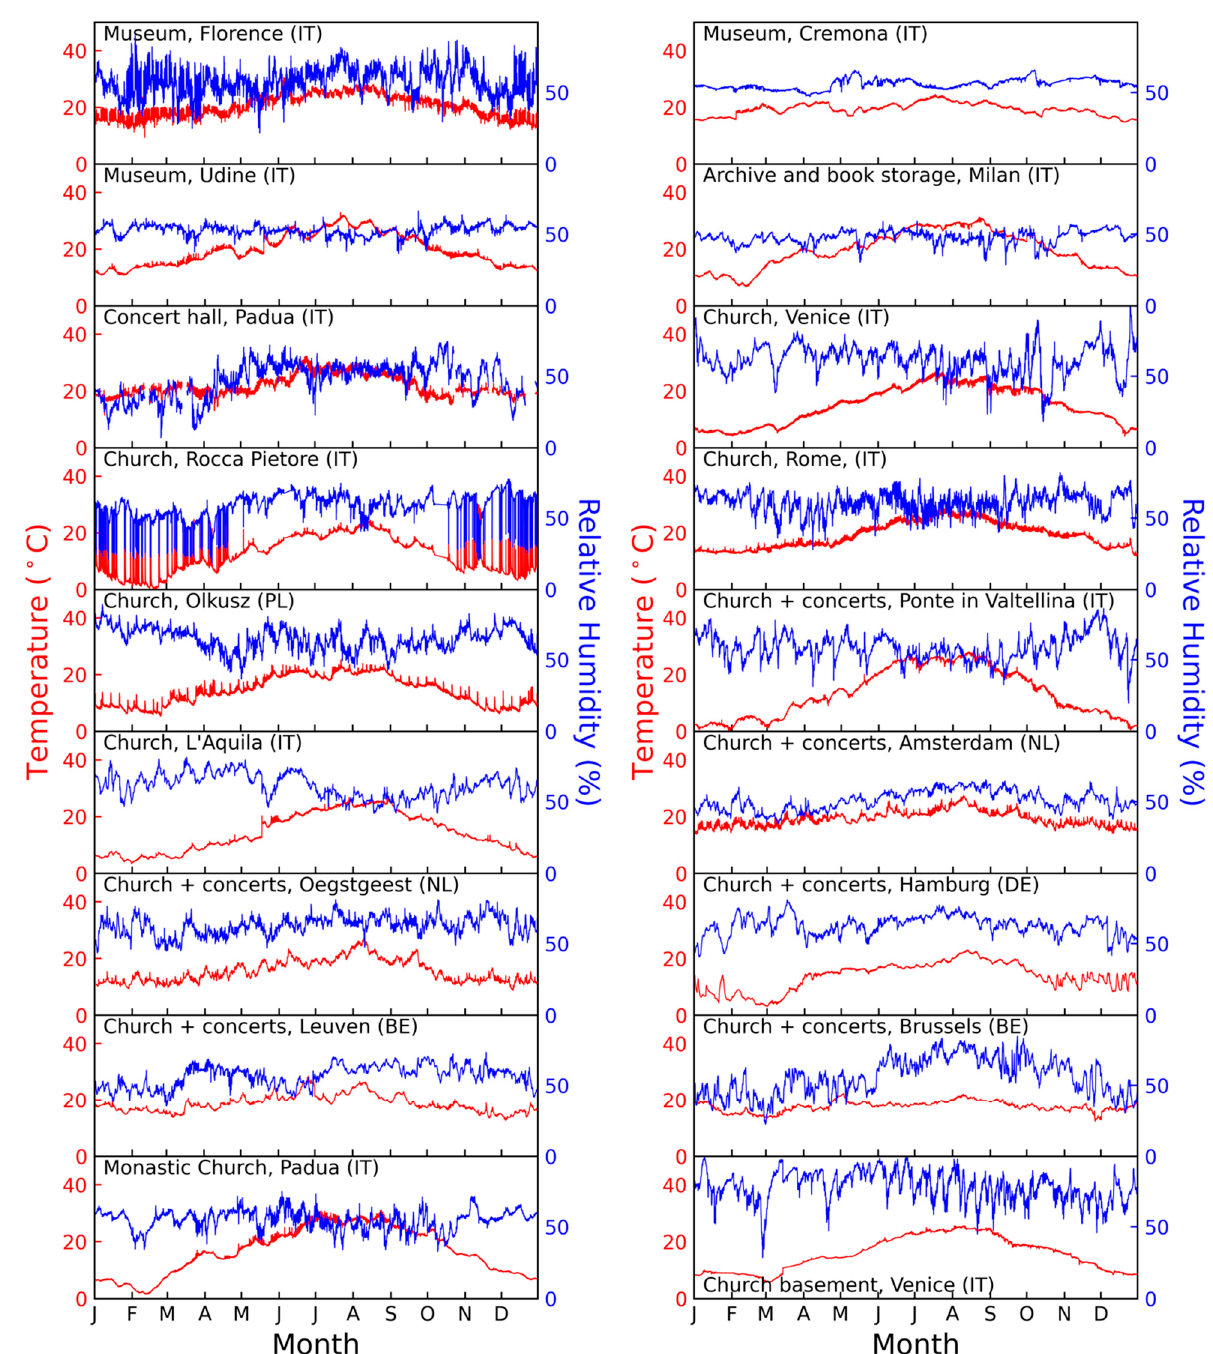
Figure 1. Indoor climate, i.e., temperature and relative humidity of the selected case